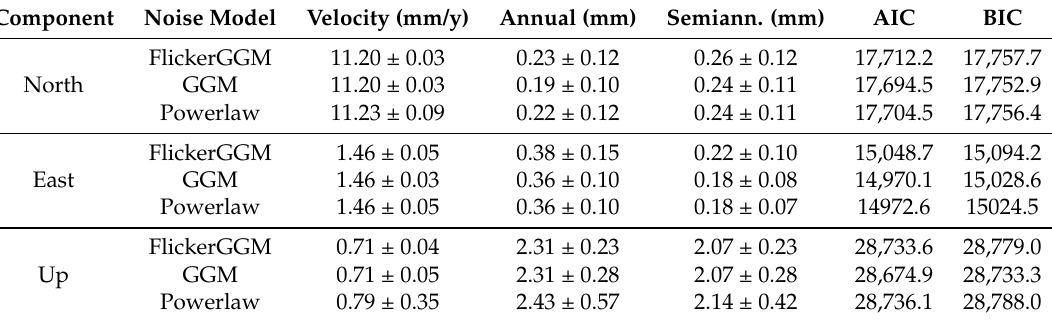
Table 5. Estimated trend and seasonality parameters for different noise models for the GIPSY solution.